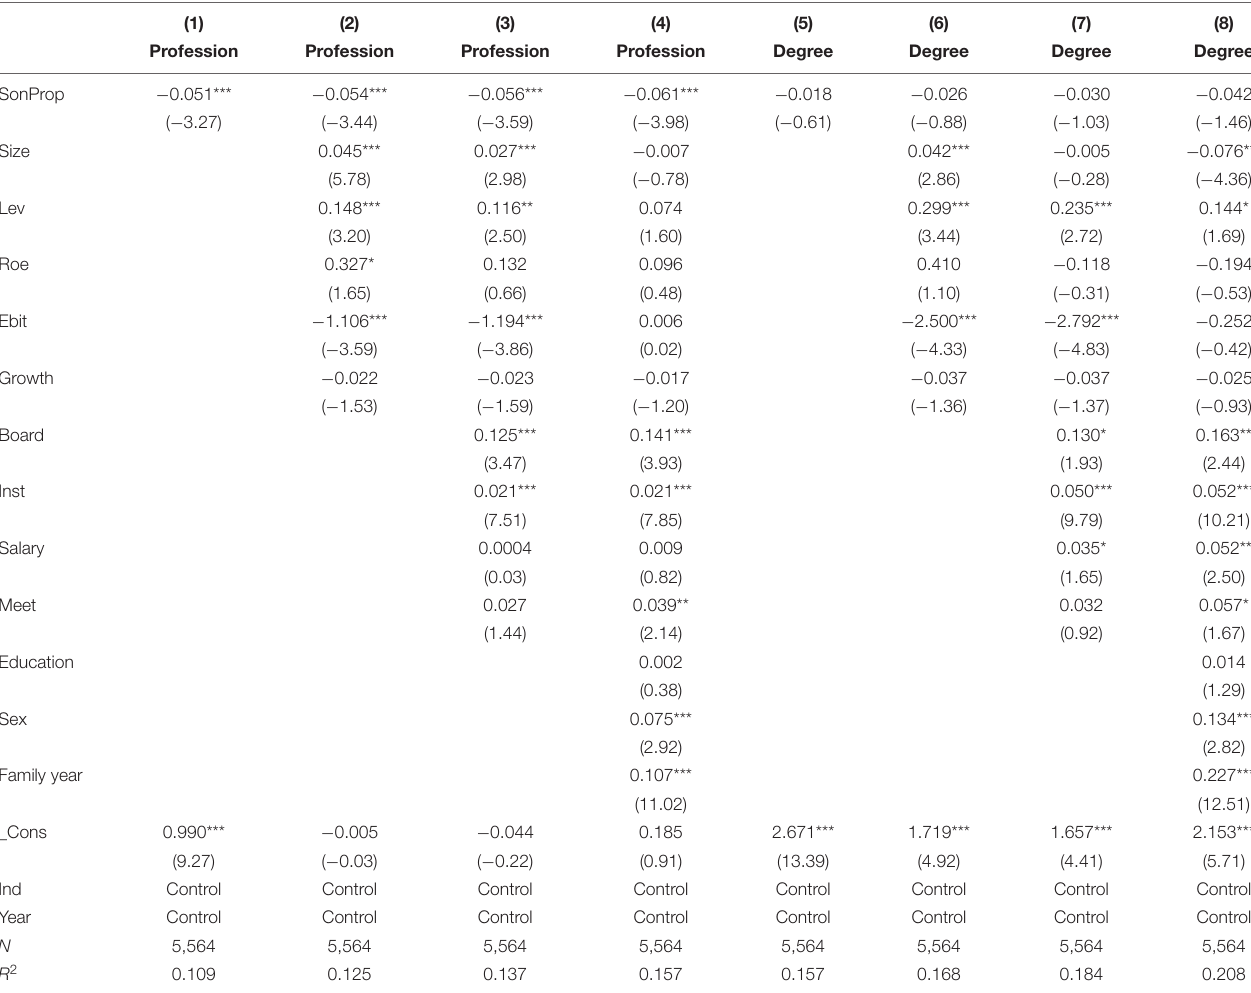
TABLE 9 | Replacement of the control variables: the proportion of sons of actual controllers and professional